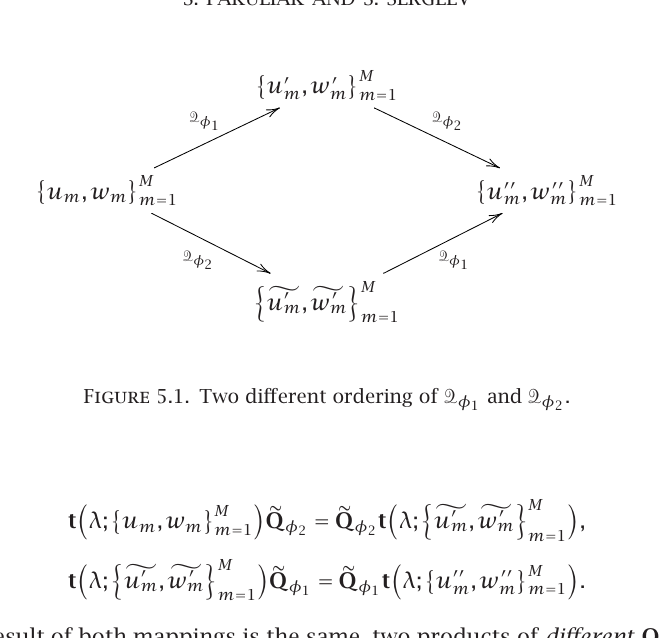
Figure 5.1 . Two different ordering of (cid:1)